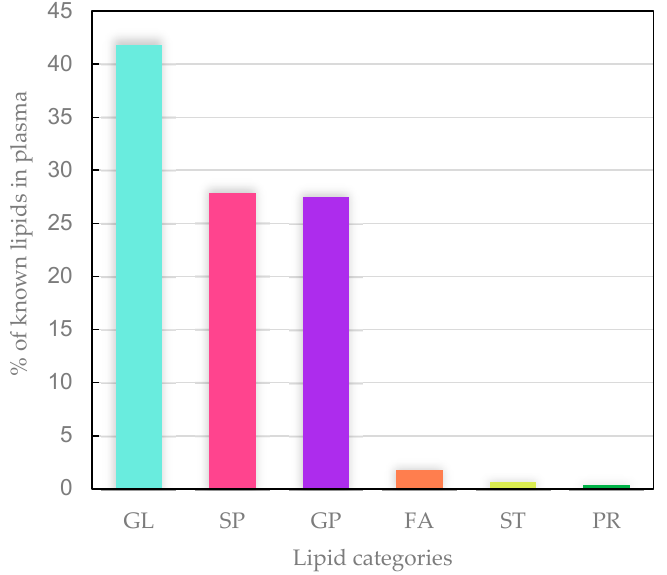
Figure 4. Percentages of the different categories of found known lipids in all lamb plasma samples. GL, glycerolipids; SP, sphingolipids; GP, glycerophospholipids; FA, fatty acyls; ST, sterol lipids; PR, prenol lipids.